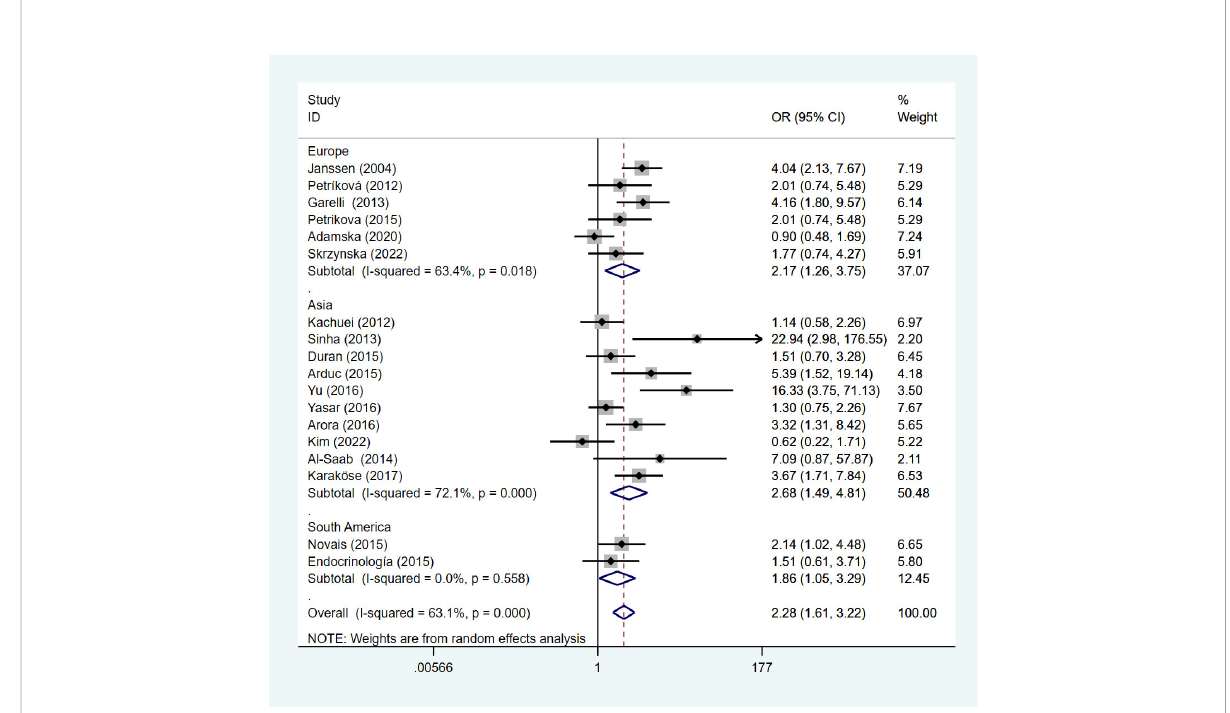
FIGURE 3 Forest plot for subgroup analysis of risk of HT in PCOS patients and non-PCOS patients by geographic